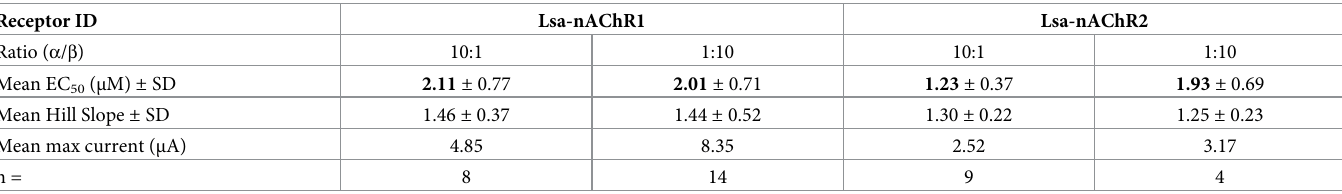
Table 1. Characterization of two different compositions of Lsa-nAChR1 and Lsa-nAChR2. The different combinations tested had no significant effect on the ACh EC 50 value on Lsa-nAChR1 while a statistically significant lower ACh EC 50 value was recorded with the α / β = 10:1 ratio for Lsa-nAChR2. "n = " refers to the number of individual cells evaluated. Receptor ID Lsa-nAChR1 Lsa-nAChR2 Ratio ( α / β